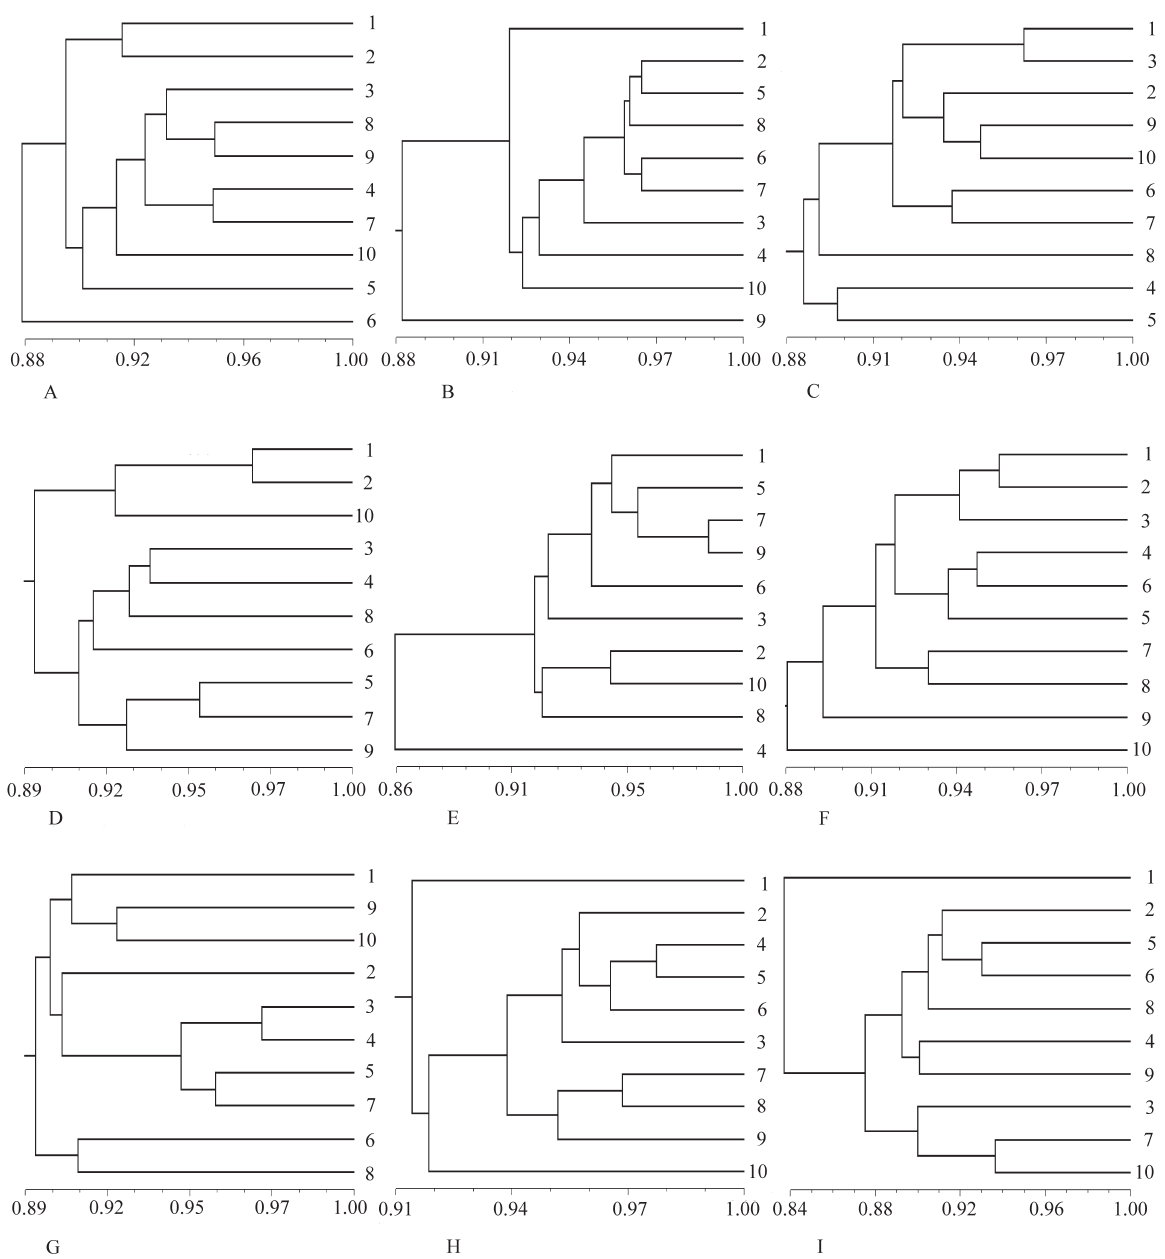
Figure 3 - Cluster diagrams based on Dice’s genetic similarity among individual plants of coffee: A. progeny IAPAR 77028-11-1; B. progeny IAPAR 77028-11-2; C. progeny IAPAR 77028-11-3; D. progeny PR 77054-40-10; E. progeny IAPAR 77028-11-4; F. progeny IAPAR 77028-11-5; G. progeny IAPAR 77028-11-6; H. cultivar Catuai Vermelho IAC 81; and I. cultivar IAPAR